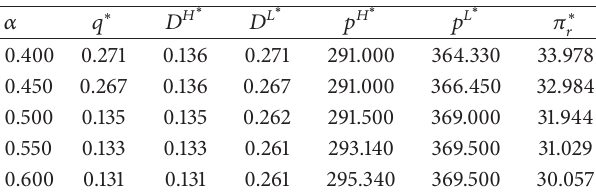
Table 2: Effects of weather